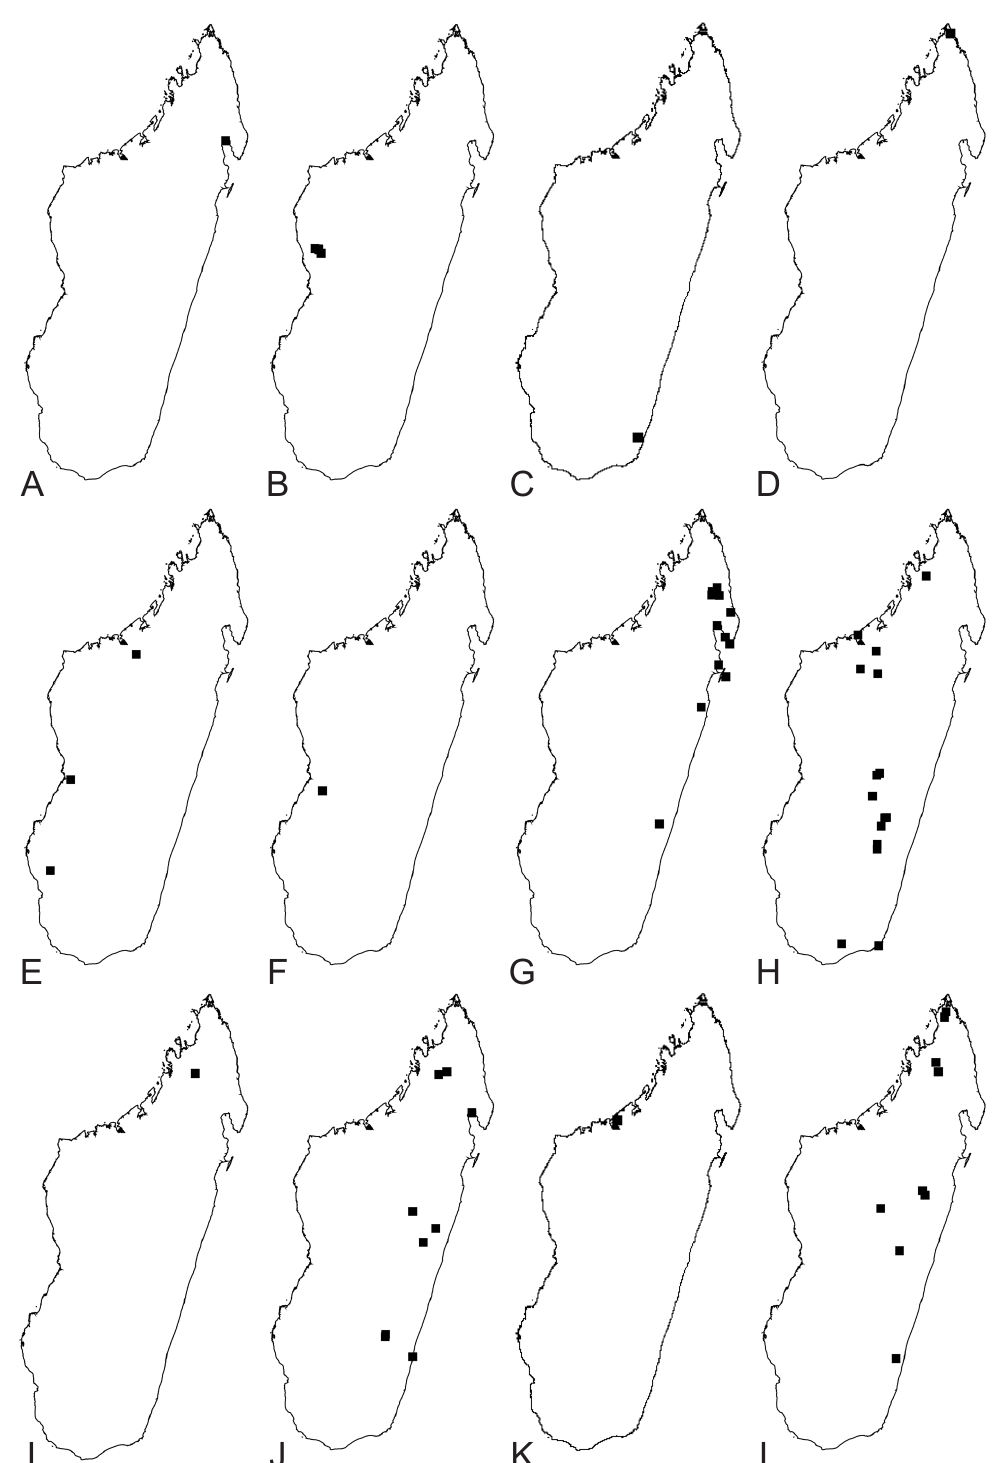
Fig. 2. Distribution maps. A . Astiella antongilensis Groeninckx sp. nov. B . A. antsalovansis